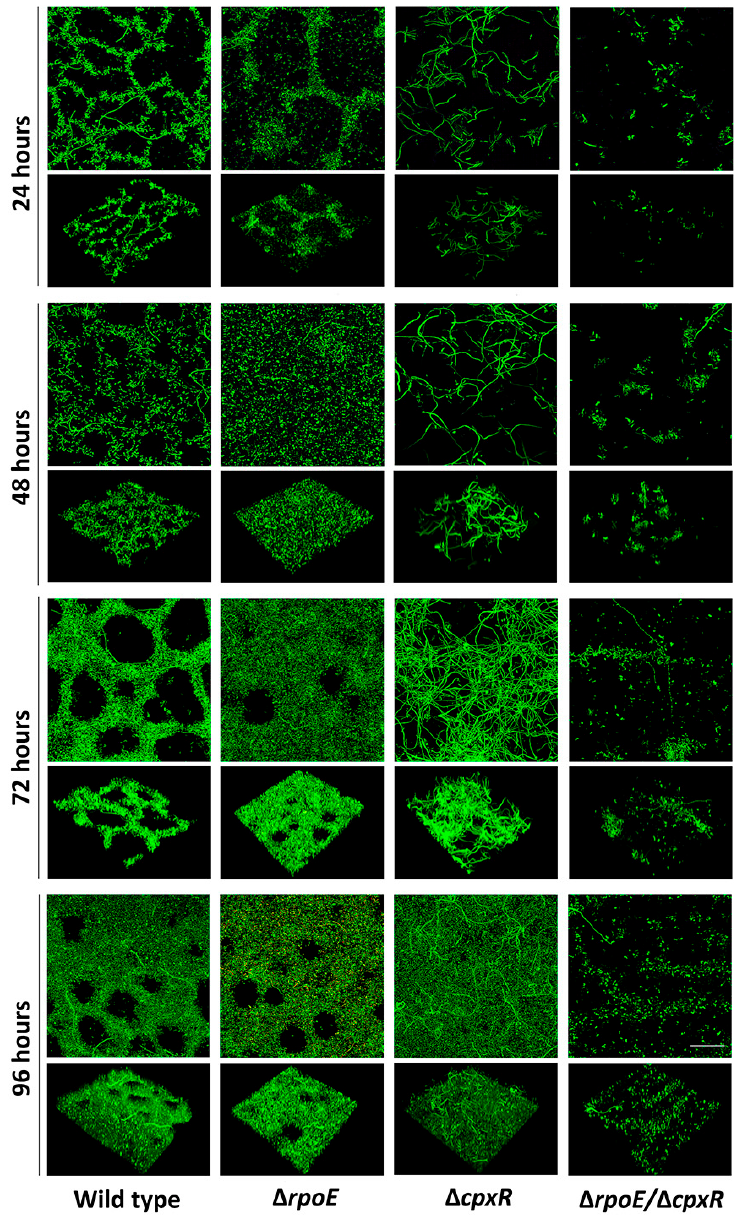
ff ect of deletion of the rpoE, cpxR and rpoE / cpxR genes on the formation of S . Figure 5. Effect of deletion of the rpoE, cpxR and rpoE/cpxR genes on the formation of S . Enteritidis Figure 5. E